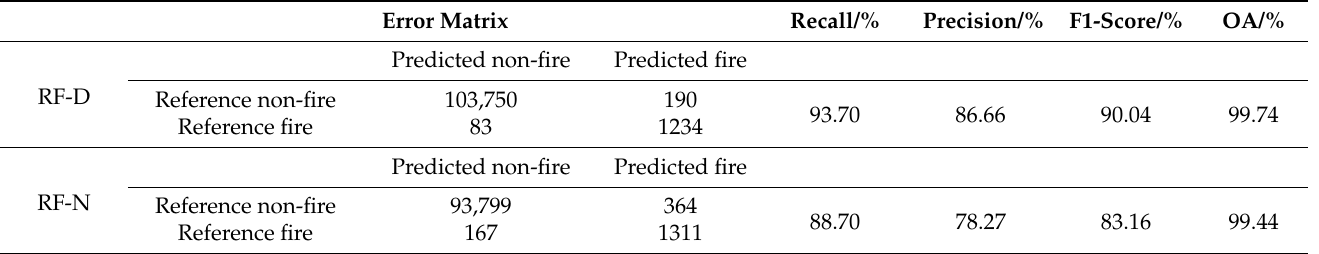
Table 3. RF-D and RF-N models accuracy assessment results on the validation dataset. Error Matrix